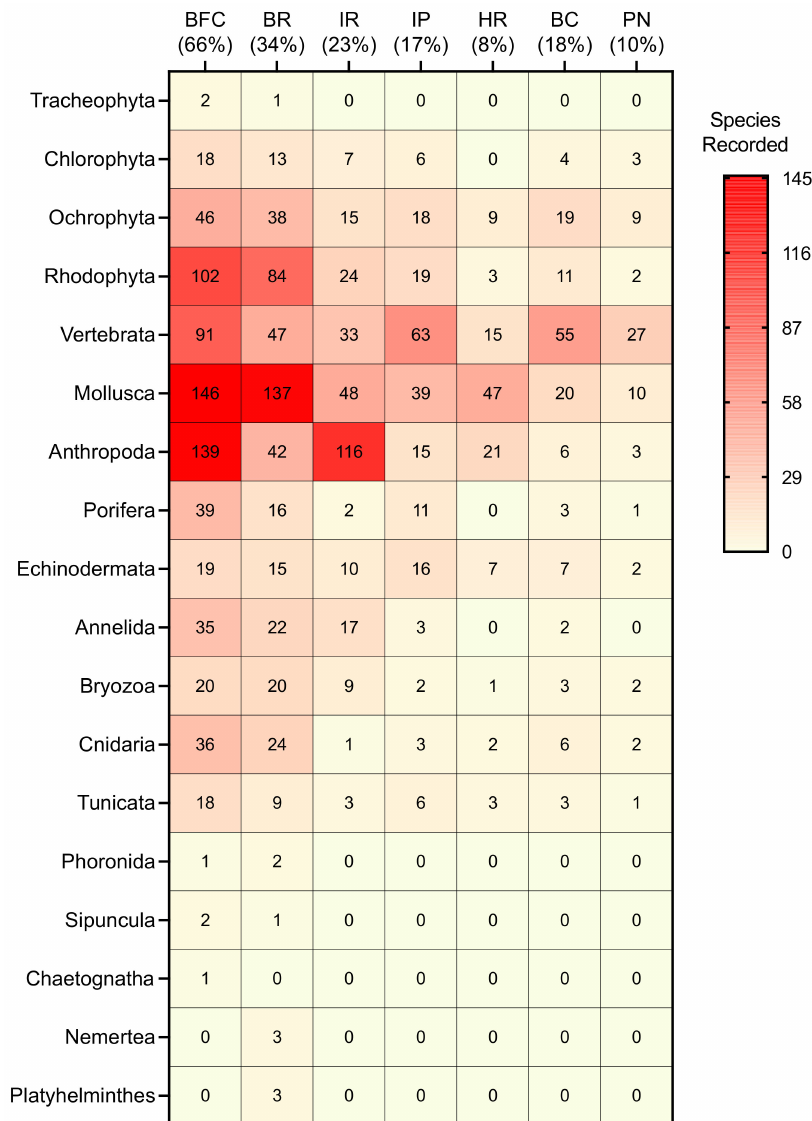
Figure 3. Heat map showing species richness of seagrasses, macroalgae, bony and cartilaginous fishes and invertebrates documented at seven reef sites in Blue Cavern Onshore SMCA. Each square indicates number of species recorded within a taxonomic group. Values in parentheses indicate percentage of studies (n = 158 total; does not include scuba-based surveys from this study) conducted at each reef site (BFC = Big Fisherman’s Cove, BR = Bird Rock, IR = Isthmus Reef, IP = Intake Pipes, HR = Habitat Reef, BC = Blue Caverns, PN = Pumpernickel Cove). Color gradient (ranging from yellow to red, as shown in key) signifies changes in the number of species present (rows) among marine taxa recorded at different study sites